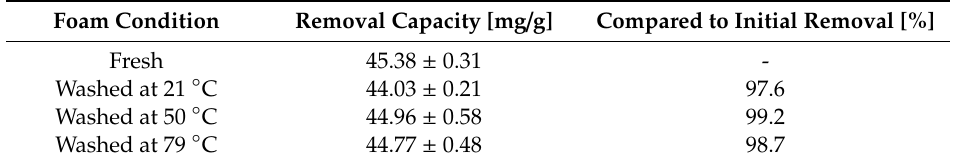
Table 3. Adsorption capacity of the standard foam washed in ethanol at di ff erent